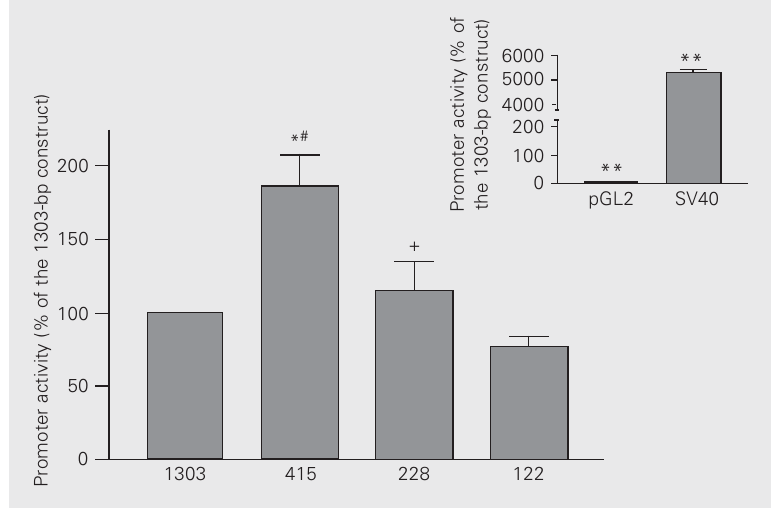
Figure 1. Mapping of elements that regulate the basal expression of the angiotensin converting enzyme (ACE) promoter in an endothelial cell line (REC). The wild type 1303-bp ACE promoter, three deletion mutants (415, 228 and 122 bp) and controls for high (SV40) or low expression (pGL2) were transfected in REC to identify ACE promoter sequences with a role in basal expression. Cells were harvested 24 h after transfection. Luciferase activity in cell extracts was normalized for beta galactosidase expression from a control plasmid. Promoter activity is the ratio of luciferase/beta galactoside expression and is reported as percent of the activity of the 1303-bp ACE promoter. Data are reported as the mean ± SEM for 4 independent experiments (N = 4 in each). Data for the reporter plasmids pGL2 and SV40 (inset) were obtained in the same experiments, but displayed separately to accom- modate large variations in scale. *P < 0.05 compared to 1303 bp, **P < 0.0001 compared to 1303 bp, # P < 0.05 compared to 228 bp, + P < 0.05 compared to 122 bp (one-way analysis of variance and post hoc Tukey